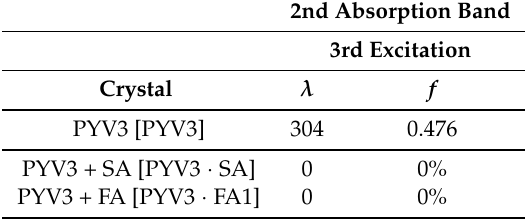
Table A8. RI-CC2/def2-TZVPD wavelengths of excitation ( λ in nm) and oscillator strengths ( f ) for the enol forms of the isolated and embedded PYV3 (PYV3 [PYV3]) and the embedded heteromers of its co-crystals (PYV3 + XXX [PYV3 · XXX]). For PYV3 [PYV3], the absolute values are given while for